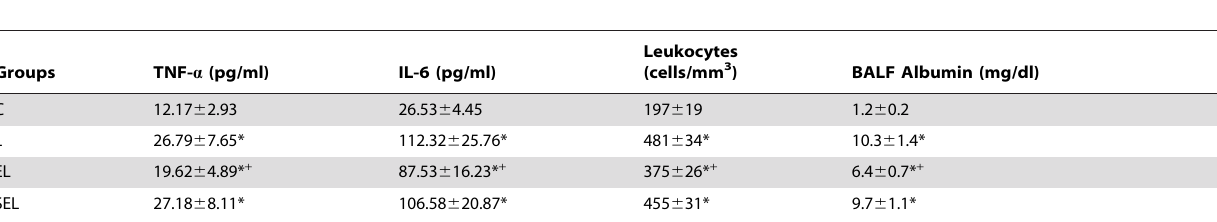
Table 3. Comparisons of plasma TNF- a and IL-6 levels and analysis of Bronchoalveolar lavage fluid.